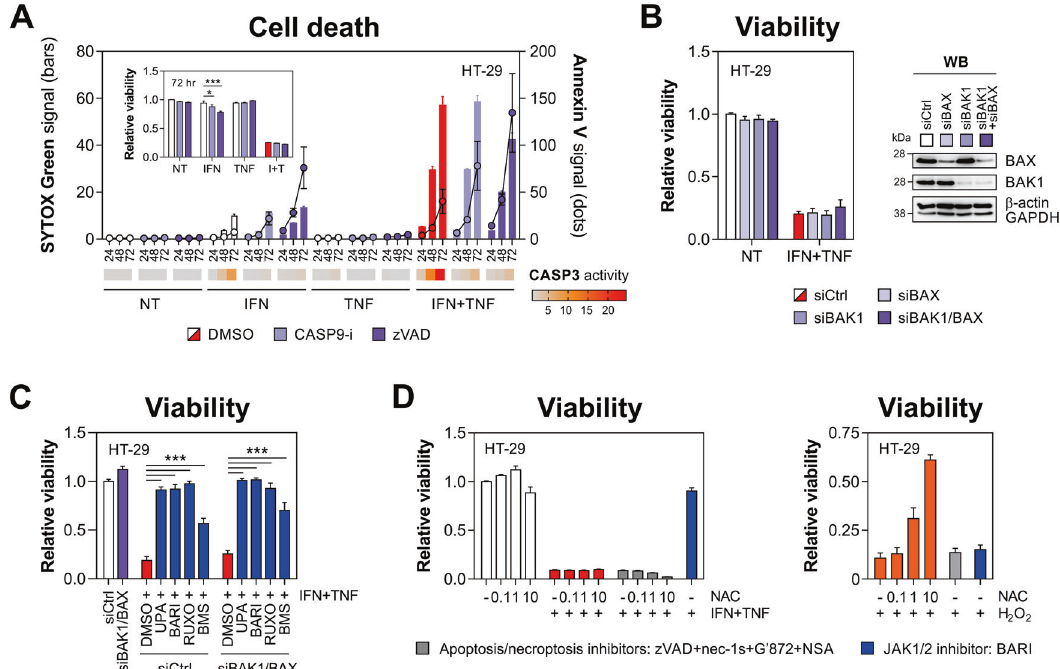
Fig. 5 IFN- γ and TNF- α kill IECs independently of mitochondrial apoptosis regulators. A HT-29 cells were pretreated for 1 h with DMSO, caspase-9 inhibitor (Z-LEHD, 10 μ M) or zVAD (20 μ M), followed by IFN- γ /TNF- α (10 ng/ml each). SYTOX Green/Annexin V signals and caspase-3 activity (heatmap) were recorded at indicated times, and relative viability was measured at 72 h (inner graph). B Relative viability of HT-29 cells transfected with siCtrl, siBAK1 or siBAX, followed by IFN- γ /TNF- α (10 ng/ml each) for 72 h (left). Western blot validation of BAK1/BAX knockdown (right). C Relative viability of HT-29 cells transfected with siCtrl or siBAK1/BAX, subsequently pretreated for 1 h with DMSO, JAK1- selective compound (upadacitinib), JAK2-selective compound (BMS-911543) or dual JAK1/2 inhibitors (ruxolitinib or baricitinib) at 1 μ M, followed by IFN- γ /TNF- α (10 ng/ml each) for 72 h. D Relative viability of HT-29 cells pretreated for 1 h with DMSO, baricitinib (1 μ M) or a cocktail of apoptosis/necroptosis inhibitors (necrostatin-1s (10 μ M), GSK ′ 872 (10 μ M), NSA (1 μ M) and zVAD (20 μ M)) and increasing concentrations of N -acetylcysteine (NAC, 0.1, 1 and 10 mM), followed by (left) IFN- γ /TNF- α (10 ng/ml each) or (right) H 2 O 2 (1 mM) for 72 h. Data were mean ± SEM of n = 3 independent experiments. * p < 0.05 and *** p < 0.001 (two-way ANOVA with Tukey ’ s multiple comparisons test). NT non-treated, nec-1s necrostatin-1s, G ′ 872 GSK ′ 872, CASP9-i caspase-9 inhibitor, UPA upadacitinib, BARI baricitinib, RUXO ruxolitinib, BMS BMS-911543, NAC N